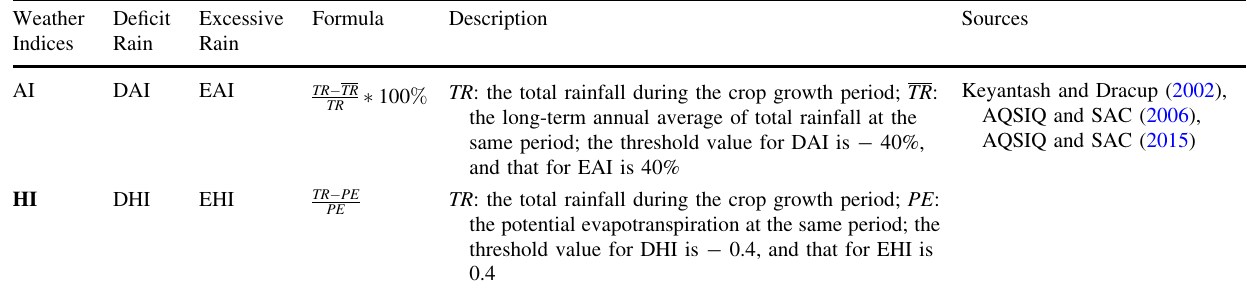
Table 2 Rainfall-related weather indices for three crops (maize, rice, wheat) Weather